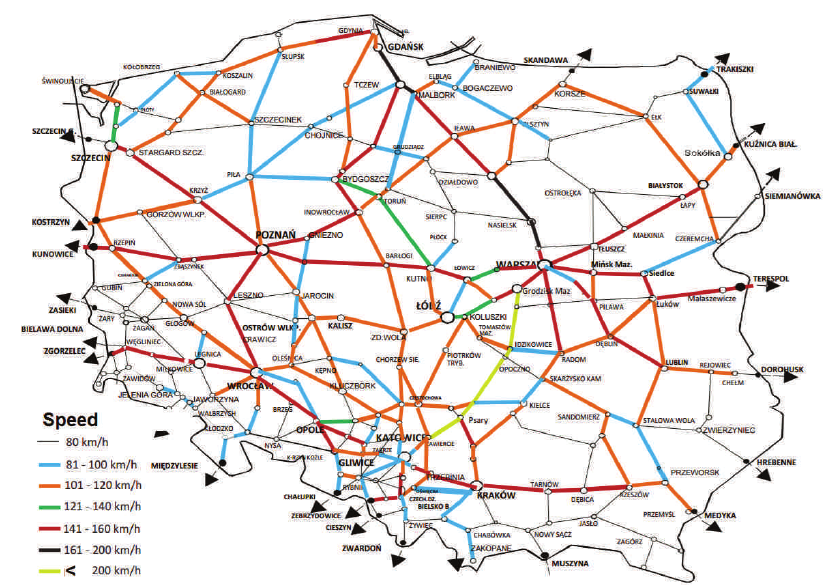
Fig. 2. Polish rail network and its maximum admissible speeds [3]